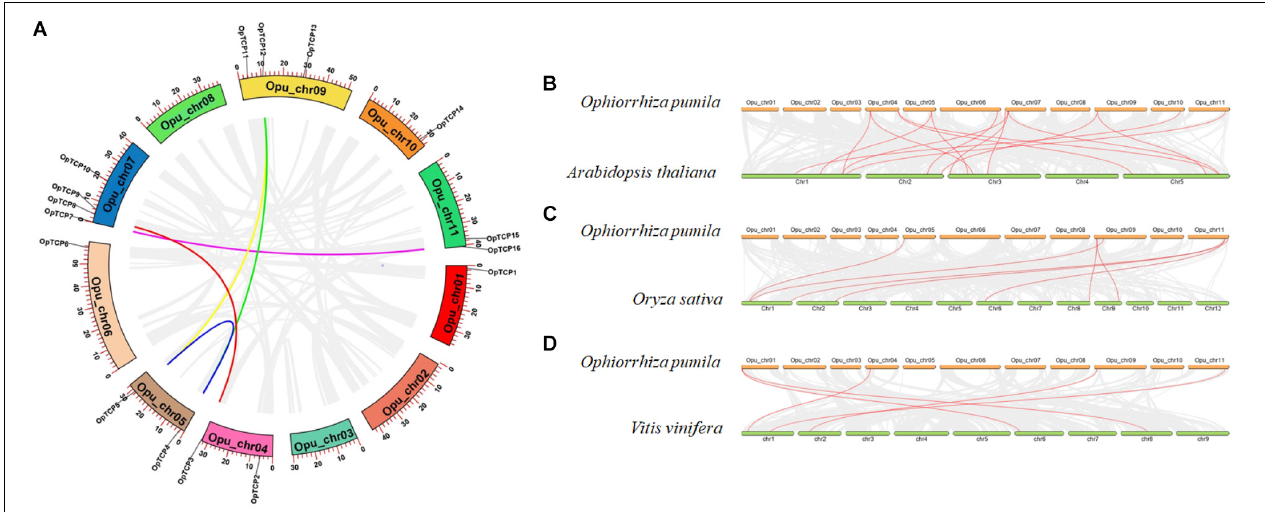
FIGURE 1 | The chromosomal location and synteny analysis of OpTCP genes. (A) Circos diagram illustrates the chromosomal locations of OpTCP genes and their synteny. The colored lines display similarity of different genes. (B–D) Synteny analysis of TCP genes between O. pumila and Arabidopsis , and rice, and V. vinifera , respectively. TCP, teosinte branched 1/cycloidea/proliferating cell factors 1/2; OpTCP, O. pumila